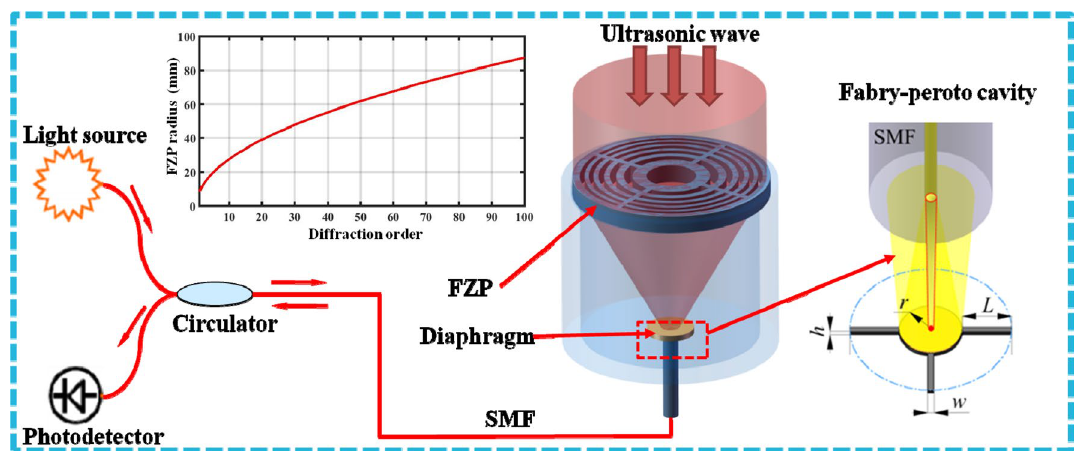
Figure 4. The schematic of the developed ultrasonic sensing system, with the inset showing the FZP radius as the diffraction order increasing and the Fabry–Perot